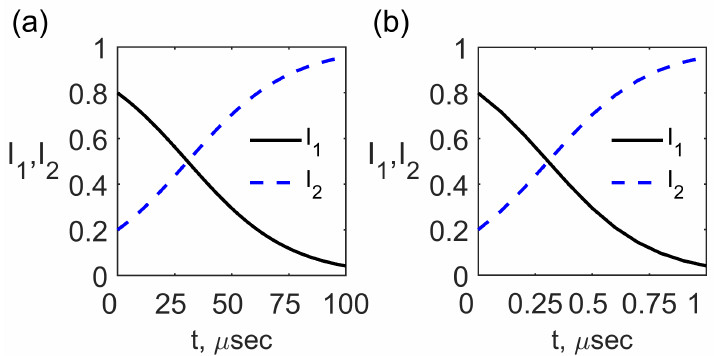
Figure 7. The time dependence of the normalized intensities I 1,2 ( t ) for the initial conditions I 1 ( 0 ) = 0.8, I 2 ( 0 ) = 0.2, pumping wavelength λ 1 = 1.55 µ m and the pumping wave electric field amplitude E 0 zSA 1 = 10 5 V/m ( a ) and 10 6 V/m ( b